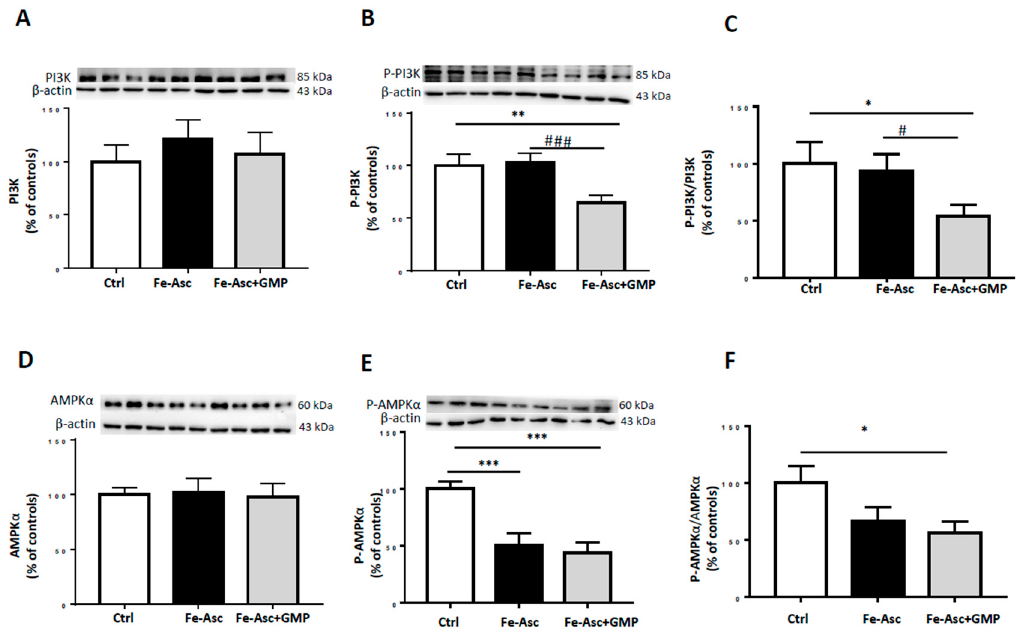
Figure 5. E ff ects of GMP on insulin signaling in Caco-2 / 15 cells. Caco-2 / 15 cells were pre-incubated for